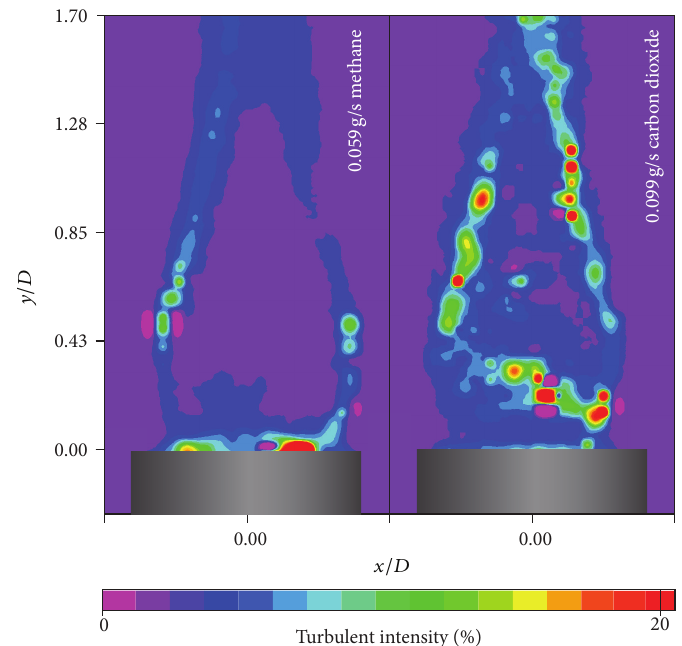
Figure 7: Comparison of turbulent intensity between flames in TP 5 and TP